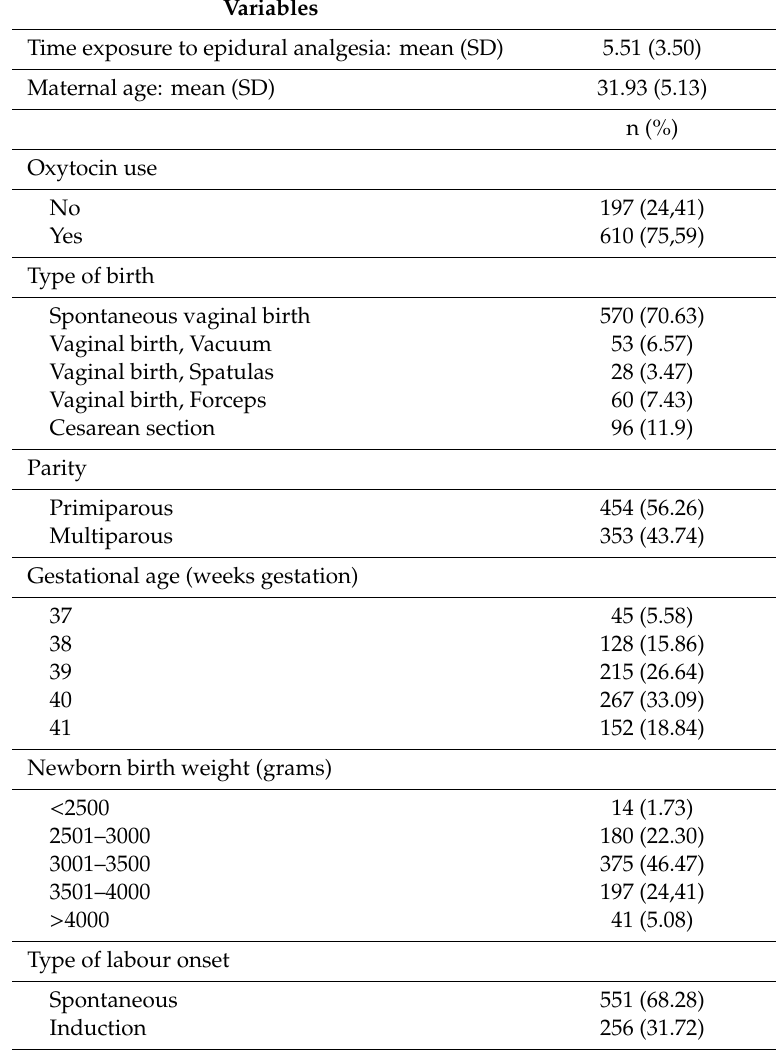
Table 2. The maternal, fetal and birth characteristics among women with epidural analgesia.